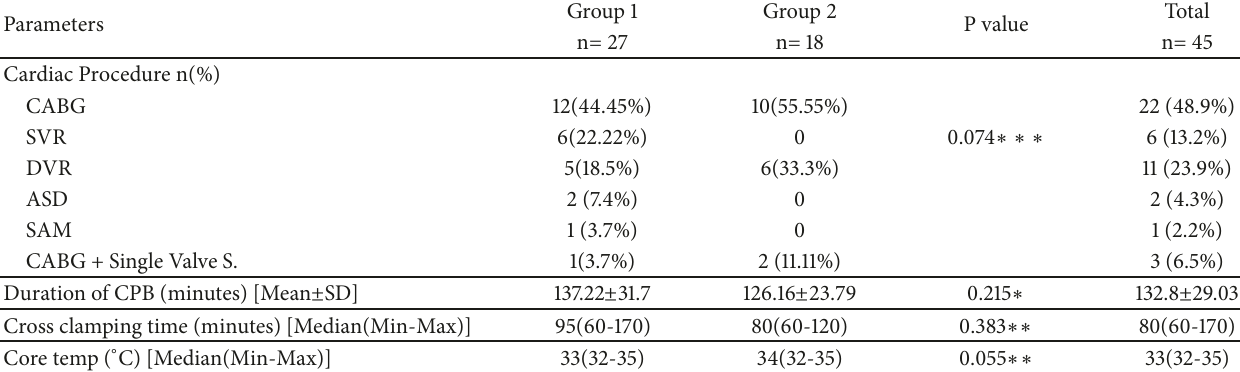
Table 2: Comparison of cardiac surgical data between AKI and non-AKI groups.